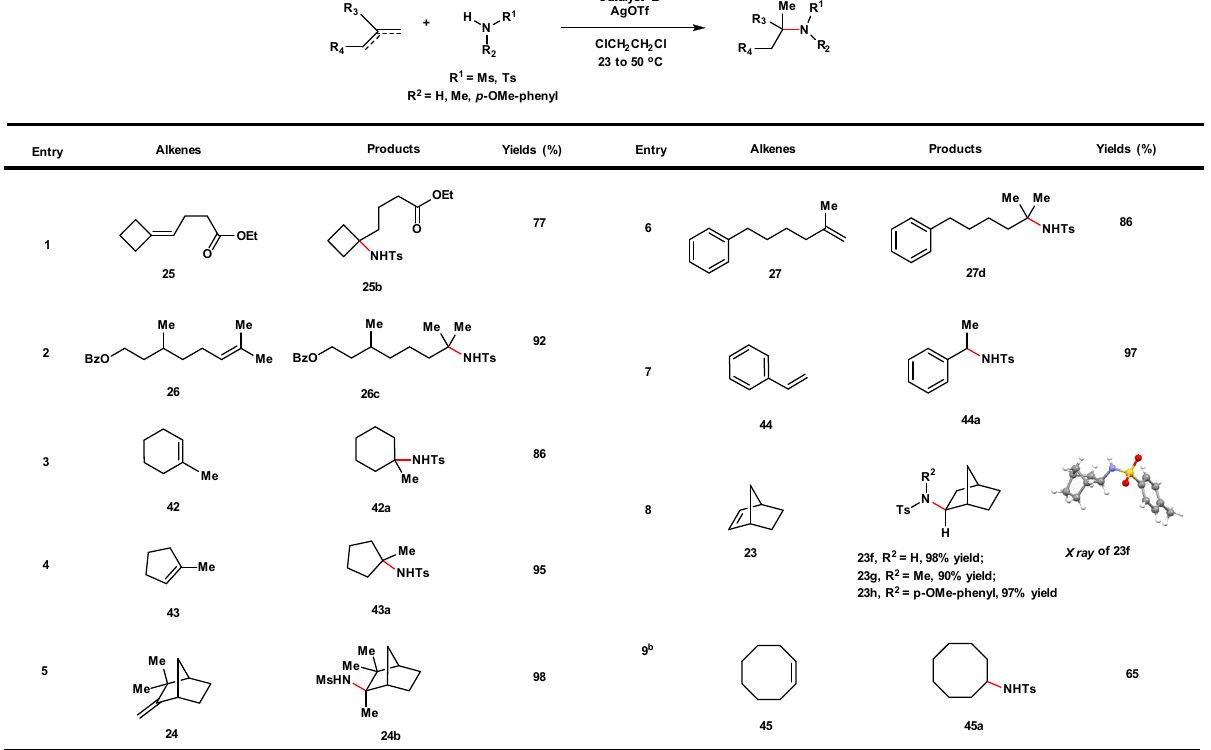
Fig. 6 Substrate scope for intermolecular hydroamination. General conditions: catalyst E (2 mol%), AgOTf (4 mol%), 23 °C, 8 – 24 h. Yields of isolated products were given. a Catalyst E (5 mol%), AgOTf (6 mol%), 50 °C, 48 h. Ts tosyl, Ms